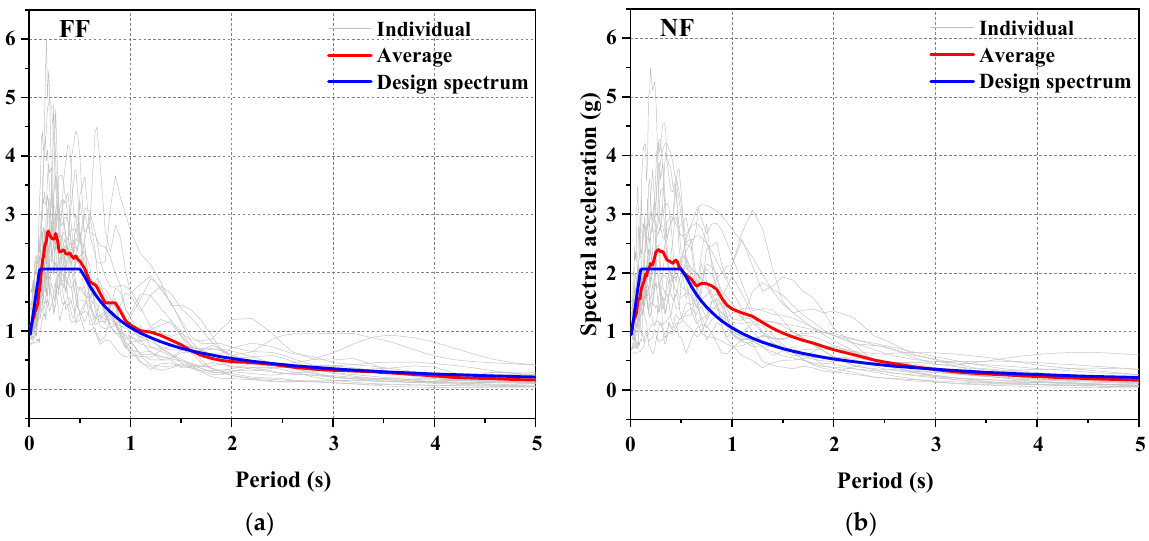
Figure 14. Response spectra of selected ground motions: ( a ) far-field (FF) ground motion records and ( b ) pulse-like near-fault (NF) ground motion records.